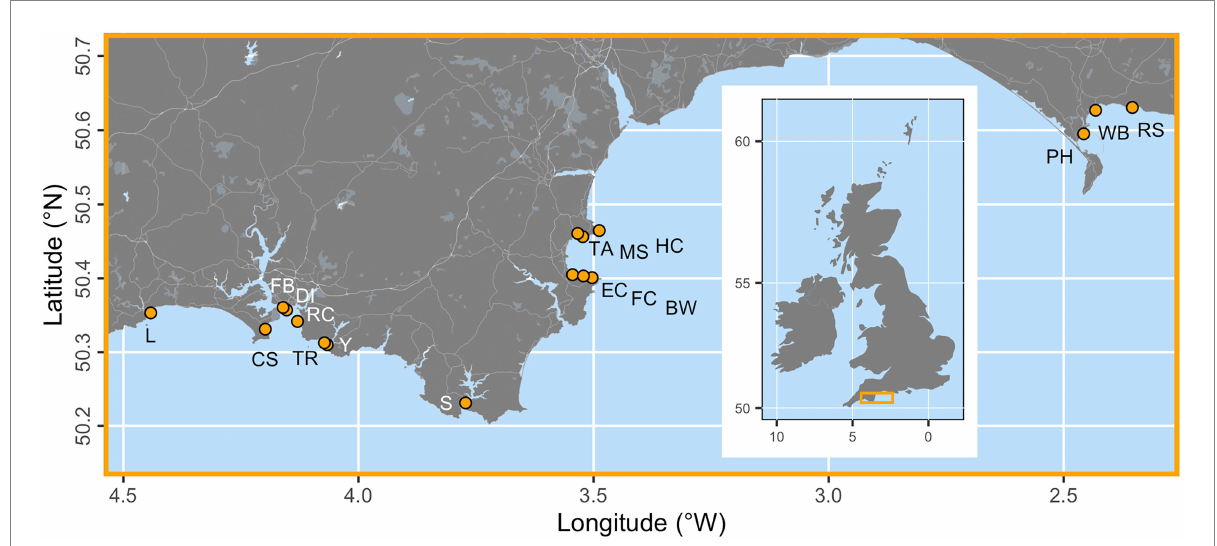
FIGURE 1 The locations of 17 seagrass study sites (orange points) across the south coast of England. Sampling locations are Looe (L), Cawsands (CS), Firestone Bay (FB), Drake’s Island (DI), Ramscliffe (RC), Tomb Rock (TR), Cellars Cove at Yealm (Y), Salcombe (S), Elberry Cove (EC), Fishcombe Cove (FC), Brixham Breakwater (BW), Torre Abbey (TA), Millstones Bay (MS), Hope Cove (HC), Portland Harbour (PH), Weymouth Bay (WB), and Ringstead Bay (RS). The inset map of the British Isles shows the placement of the main map as an orange